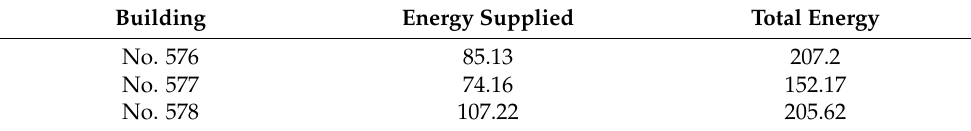
Table 5. Energy Consumption Values in kWh/(m 2 .y) After